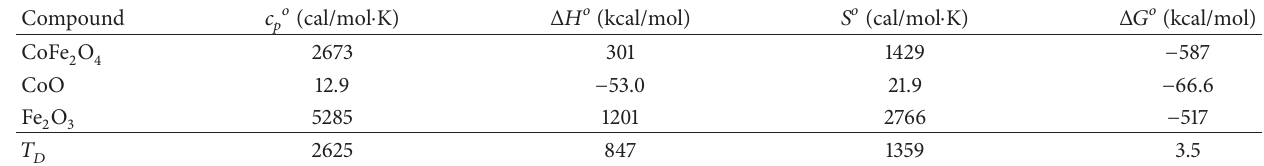
Table 5: Thermodynamic parameters for cobalt ferrite decomposition at the decomposition temperature.